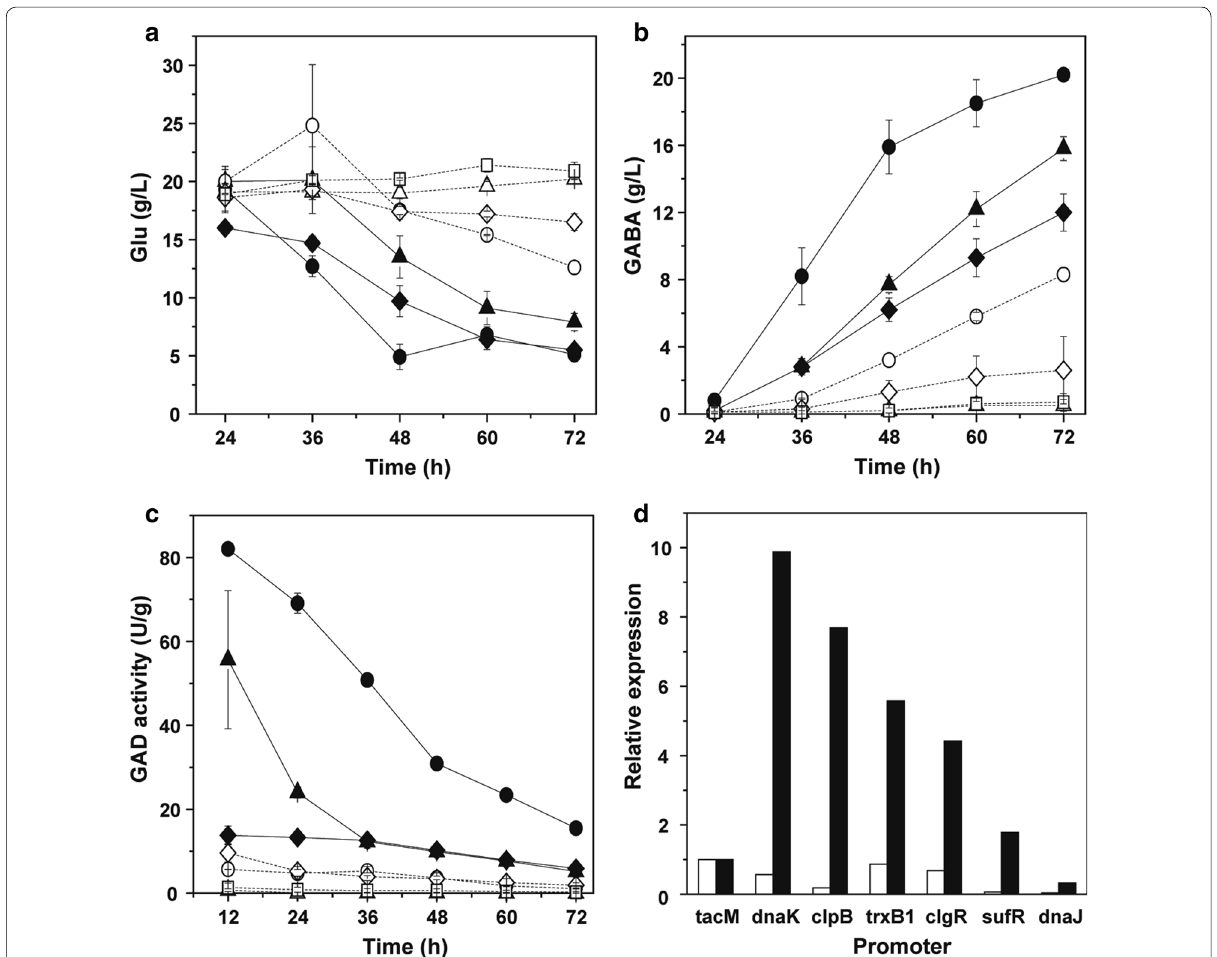
Fig. 5 GABA fermentation of gadB2 -expressing C. glutamicum strains controlled by some stress-response promoters. a Glu concentration, b GABA concentration, c GAD activity, d gadB2 transcription level. Circles R4a-B2, triangles P dnaK -B2, diamonds P clgR -B2, empty circles in dotted line P clpB - B2, empty diamonds in dotted line P trxB1 -B2, empty squares in dotted line P dnaJ -B2, empty triangles in dotted line P sufR -B2. White bars at 20 h, black bars at 40 h. Each point represents the average of three independent